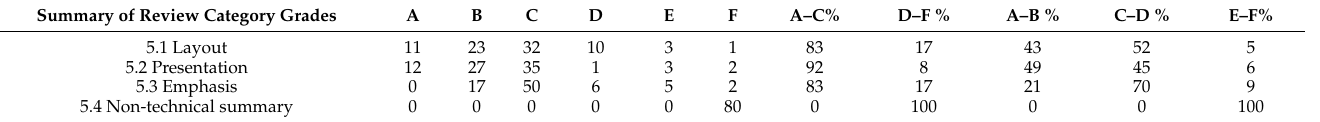
Table 9. Allocation of quality to environmental assessment tasks performed under Review Area 5.